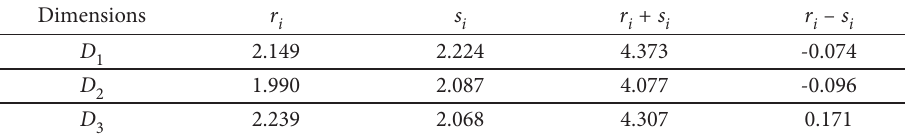
Table 7. The influential network relationships on dimensions Dimensions r